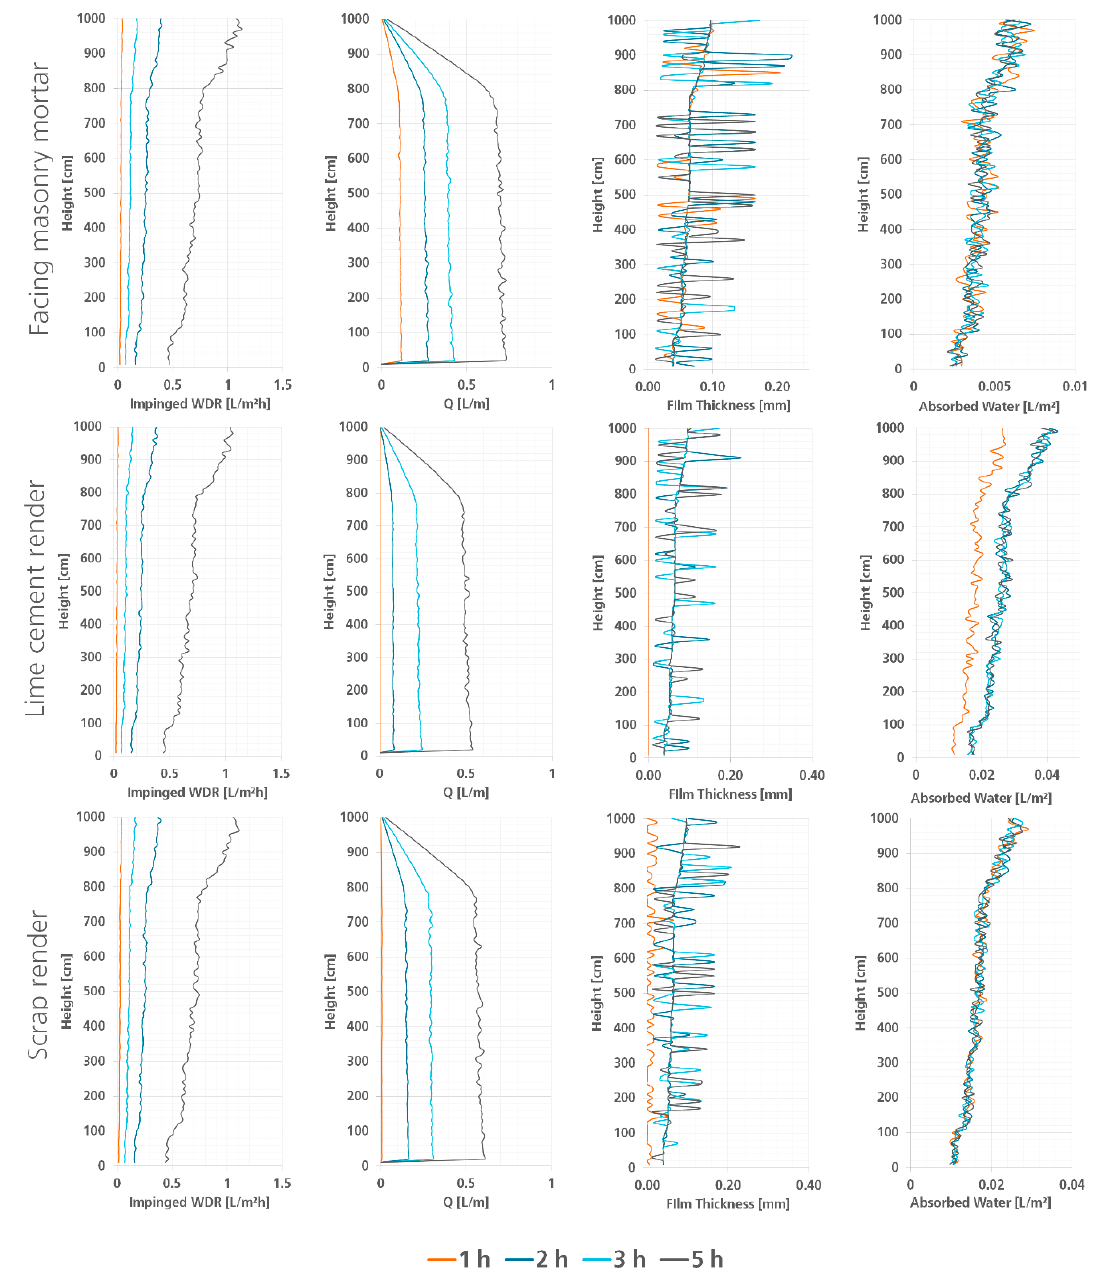
Figure 4. Impinged wind-driven rain during 1 h, 2 h, 3 h and 5 h intervals. Corresponding numerical